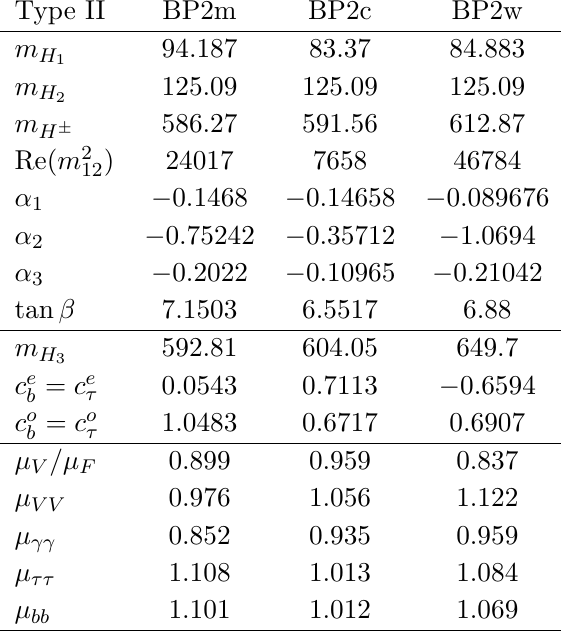
= H . Lines 125 2 . 125